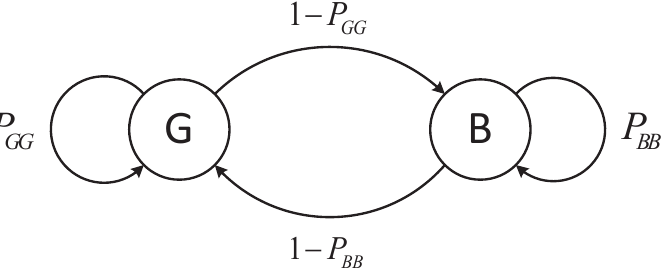
Figure 10. A GE channel model with good (G) and bad (B) states.